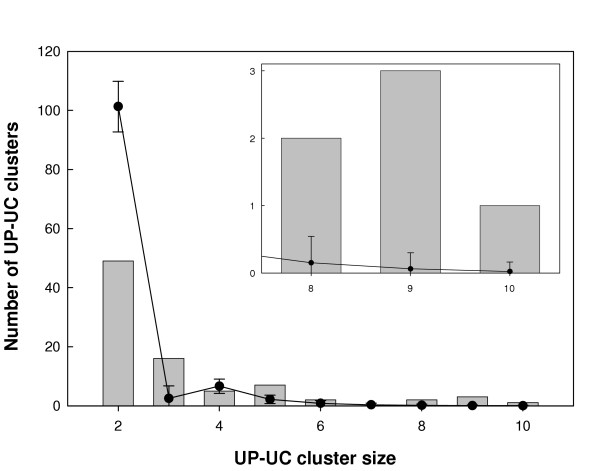
Frequency histogram of UP-UC cluster sizes in the E. coli metabolic network (grey bars). Data is shown in Supplementary Table S5 (see Additional File 1). The black line is the frequency distribution for the randomized versions of the network (averaged over 1000 realizations) that preserve the in- and out-degree of all nodes. Error bars show one standard deviation of the randomized ensemble. Inset: Enlargement of the graph for the larger sized clusters. In the real network, larger UP-UC clusters (size ≥ 8) occur much more often than in the randomized version (p < 0.001). On the other hand, smaller UP-UC clusters (size ≤ 3) occur much less often than in the randomized version (p < 0.001).